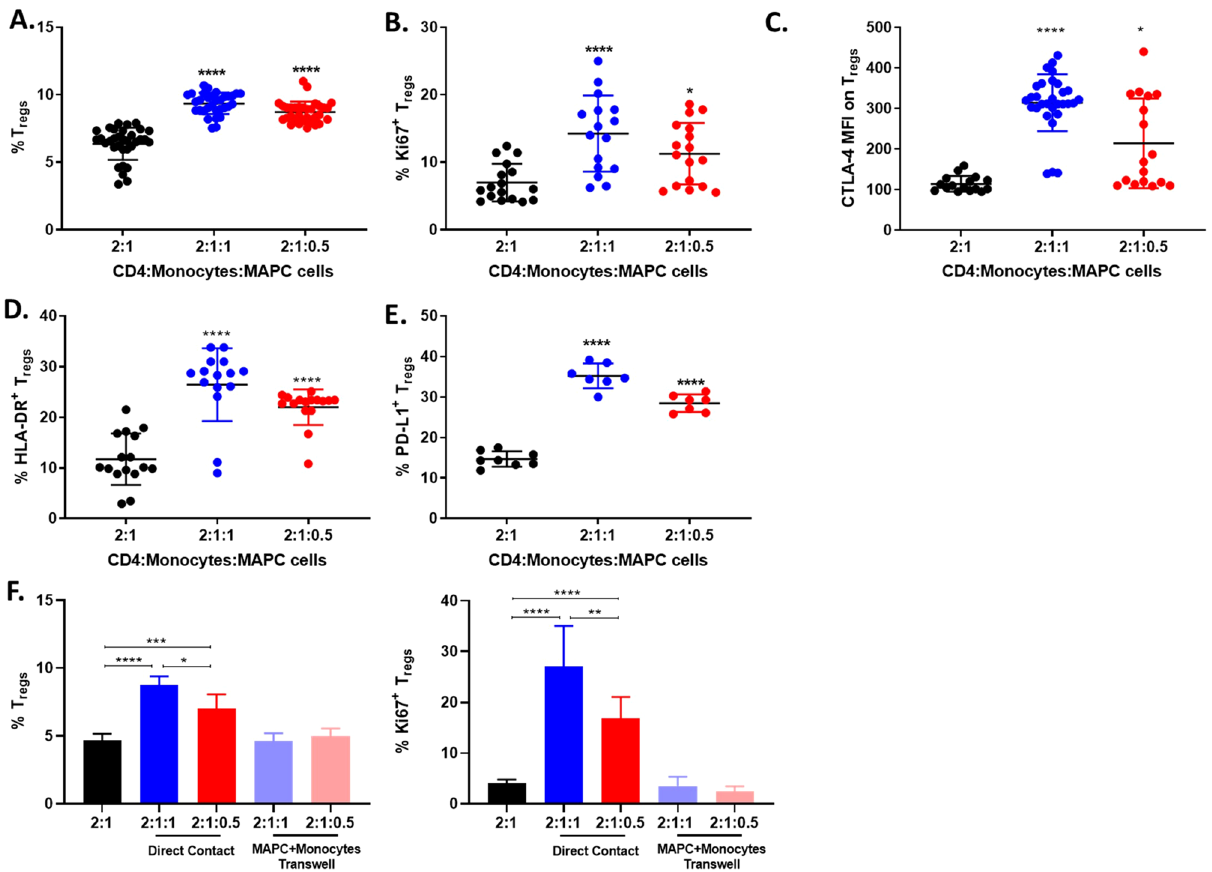
Figure 7. Co-culture of isolated CD4 + T cells and CD14 + monocytes with MAPC cells induce Treg. ( A ) Quantification of Treg percentages after 7-day co-culture of isolated CD4 + T cells and CD14 + monocytes (2:1 CD4 + T cell:CD14 + monocytes) with MAPC cells at 2:1:1 (blue) or 2:1:0.5 (red). Graphs showing quantification of ( B ) Ki67, ( C ) CTLA-4, ( D ) HLA-DR, and (E ) PD-L1 expression on Tregs . Data represent mean ± SD from pooled samples of foue independent experiments with 4 different PBMC donors and 3 MAPC cell donors. Statistical analysis was performed using Two-way ANOVA with a Tukeys’s multiple comparisons test (****p < 0.0001 and *p < 0.05). ( F ) Quantification of Treg percentages and Treg expression of Ki67 after 7-day co-culture of isolated CD4 + T cells with CD14 + monocytes and MAPC cells at 2:1:1 and 2:1:0.5 in direct contact or with MAPC cells and CD14 + monocytes in Transwell. Data represented as mean ± SD from pooled samples of two independent experiments with two different PBMC donors and 2 MAPC cell donors. Statistical analysis was performed using Two-way ANOVA with a Tukeys’s multiple comparisons test (****p < 0.0001, ***p < 0.001; **p < 0.01, and *p <